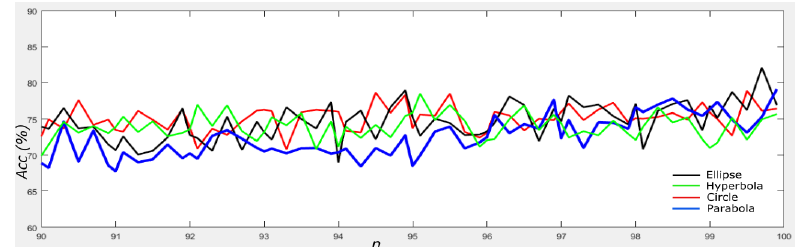
Figure 15. Quantitative results (InBreast dataset [15]) of LQP medium from the fibro-glandular disk region on different neighbourhood topologies. Note that the x- axis and y- axis represent the accuracy (percentage of correctly classified cases) and the percentage of dominant patterns,